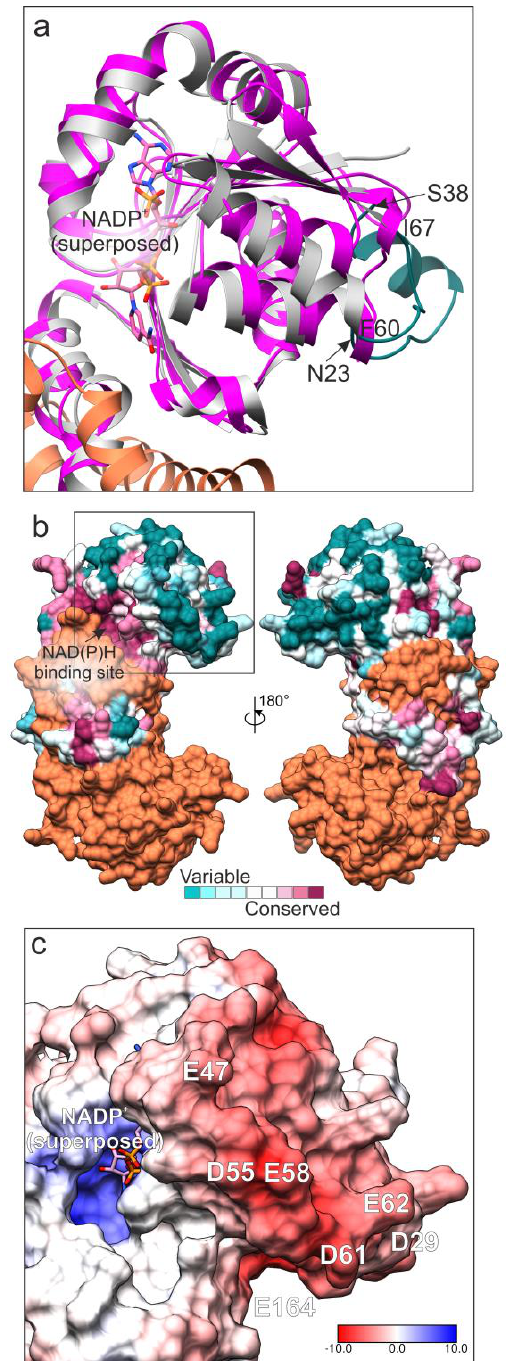
Figure 8. Analysis of the predicted structure of yeast P5C reductase. The three-dimensional model was built using the ColabFold implementation of AlphaFold [27]. A homodimer is shown for clarity, although the protein forms homodecamers. Panel a shows a comparative analysis of the ScPro3 model and the experimental structure of MtP5CR (magenta) in complex with NADP + (PDB ID 5bsg, [35]). The variable fragments in the yeast enzyme (F60-I67 and N23-S38) are green. In (panel b ), residue conservation is mapped on the ScP5CR surface for one subunit according to the color key (bottom); the second subunit is coral. The orientation on the left side in (panel b ) is the same as in (panel a ); the black rectangle indicates the fragment in (panels a and c ). Surface electrostatic potential is shown in (panel c ) for the same region as in ( a ); the color key is in kT/e. Negatively charged residues at variable positions are labeled.